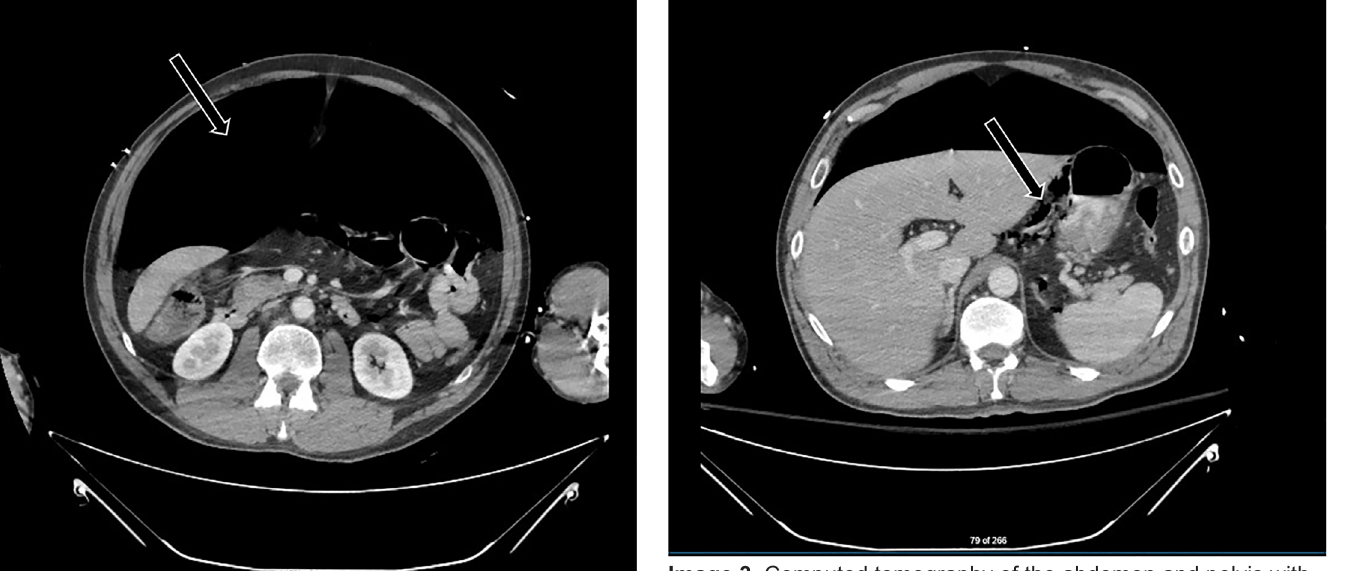
Image 3. Computed tomography of the abdomen and pelvis with oral contrast at the level of the stomach performed after needle decompression. Large pneumoperitoneum was still present but without tension. Arrow points to air bubbles seen along lesser gastric curvature suggesting location of